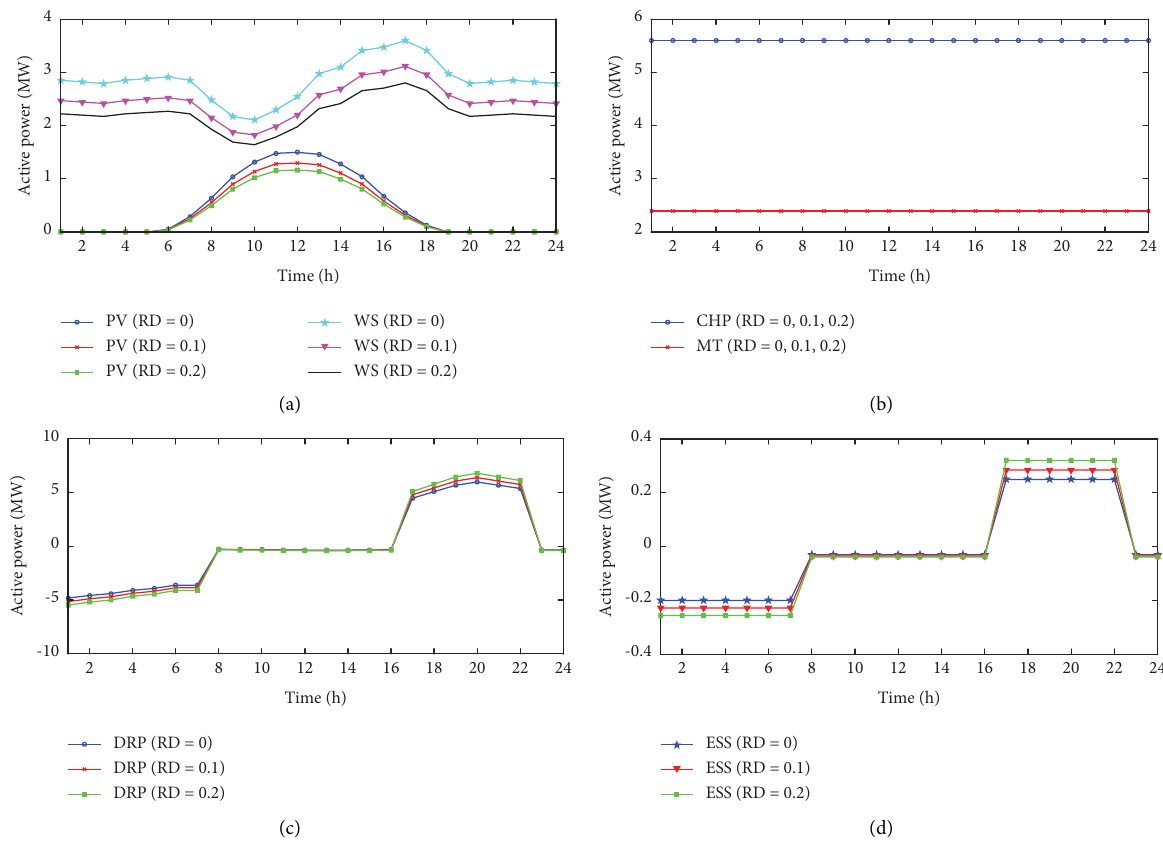
Figure 4: Daily active power curves of (a) RESs, (b) non-RESs, (c) DRPs, and (d) ESSs at diferent values of robustness